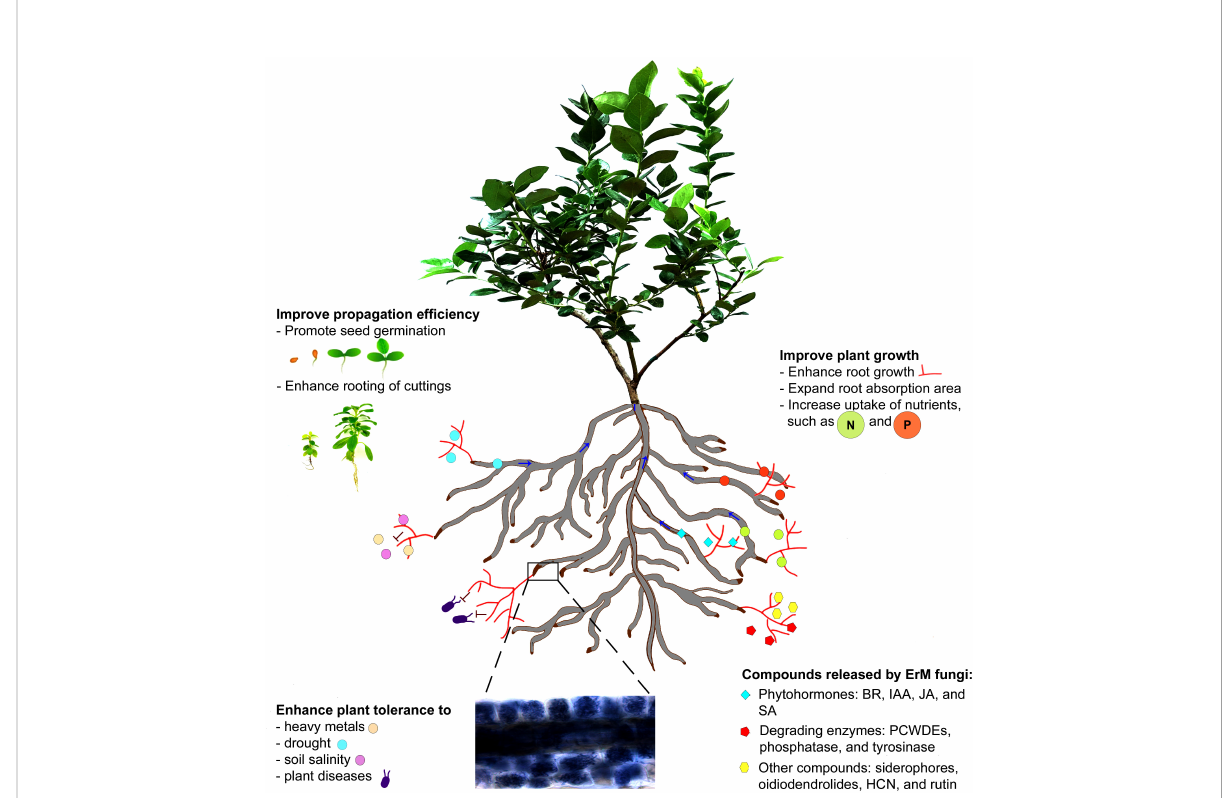
FIGURE 1 A schematic illustration of ericoid mycorrhizal fungi in establishment of the symbiotic relationship with an ericaceous plant (blueberry) and production bioactive compounds, which result in the improved seed germination and rooting of cuttings, and the symbiosis also enhances plant tolerance to different abiotic stresses and resistance to pathogen infections and promotes plant